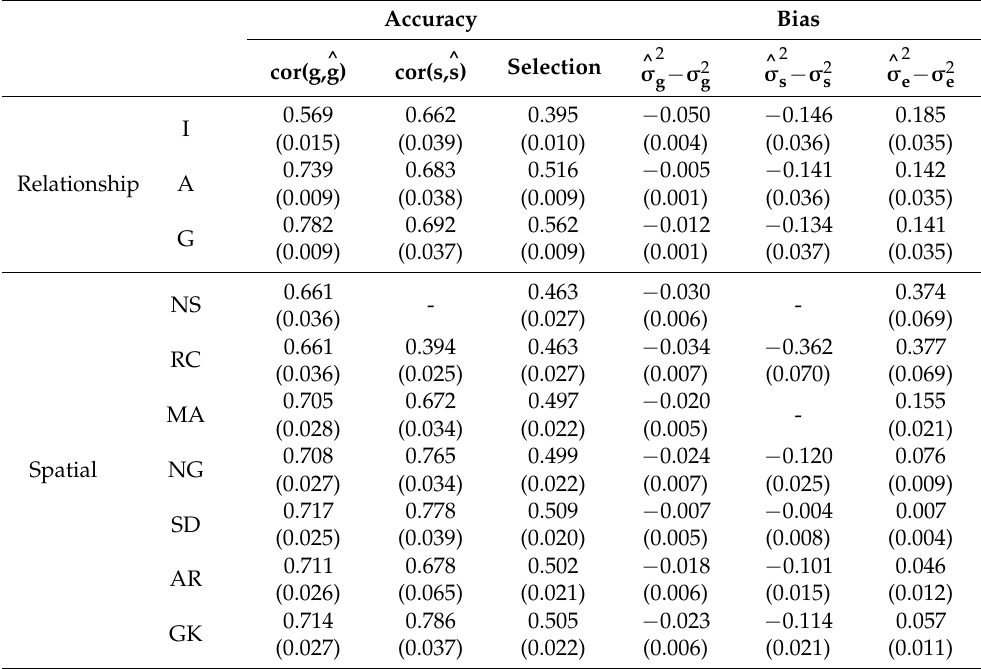
Table 1. Marginal treatment averages and standard error across residual-to-spatial variance